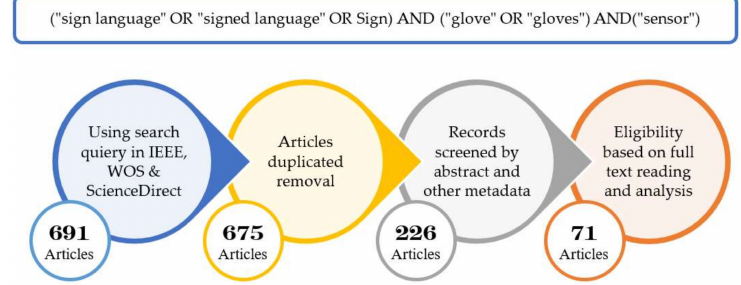
Figure 15. The searches query and article selection processes adopted in this study.